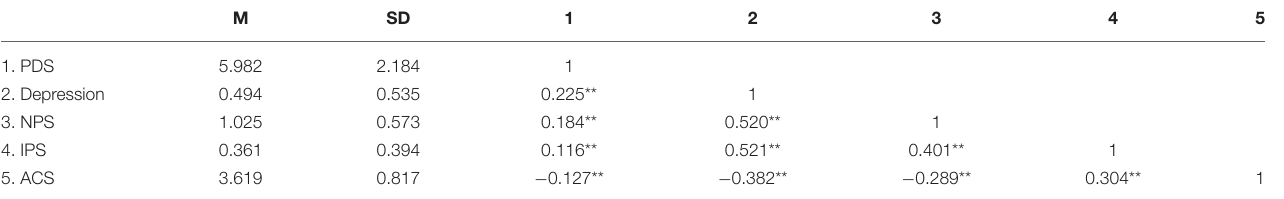
TABLE 1 | Descriptive data and zero-order correlations across variables.